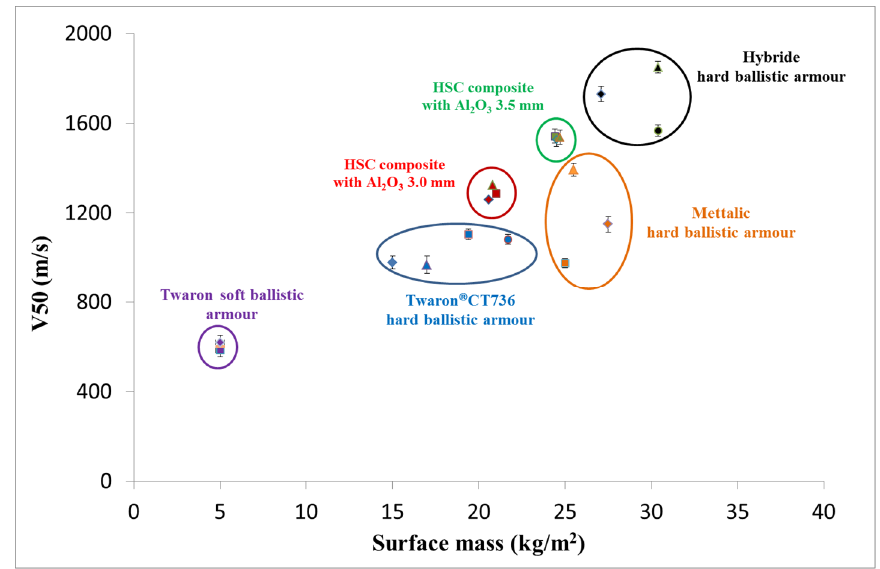
Figure 5. Dependence of V50 with the FSP.22 fragment of mass (1.10±0.03) g on the surface mass for Figure 6. Dependence of V50 with the FSP.22 fragment of mass (1.10 ± 0.03) g on the surface mass